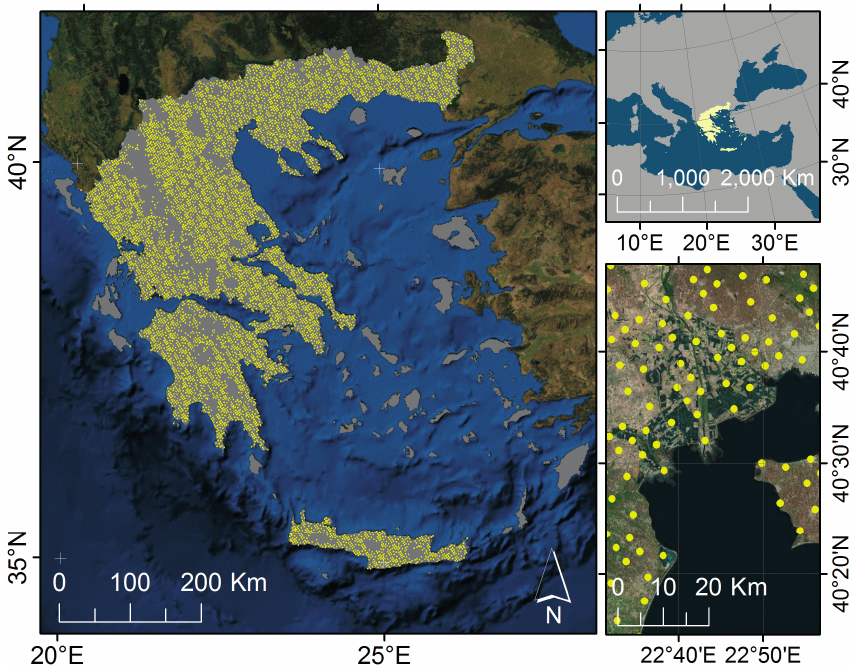
Figure 1. Located at the southern edge of the Balkan Peninsula, SE Europe (top right inset), Greece was covered by 73% by the LUCAS 2009 Survey (yellow dots). In the (bottom right inset), a closer view of LUCAS points is shown (approx. regular grid of 2.8